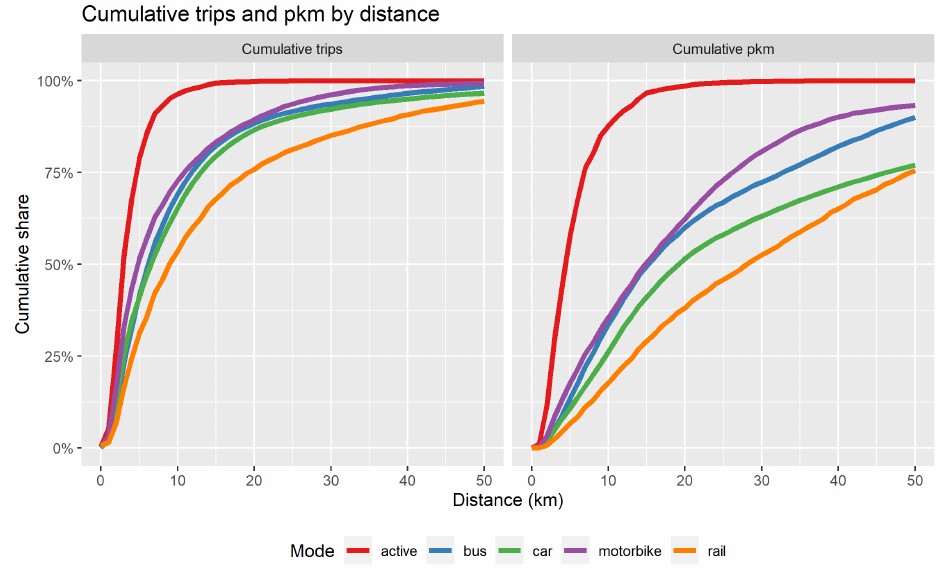
Figure 3. Cumulative commuting trips in Lombardy, by % of trips, and by % of passenger km